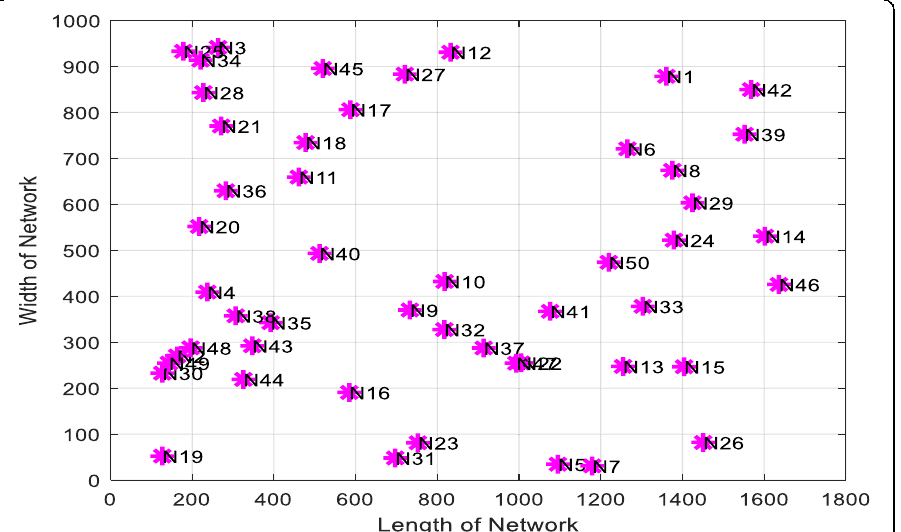
Fig. 3 Network topology. The nodes in the magenta color are distributed in random locations and the network topology changes as a result of the mobility feature of the